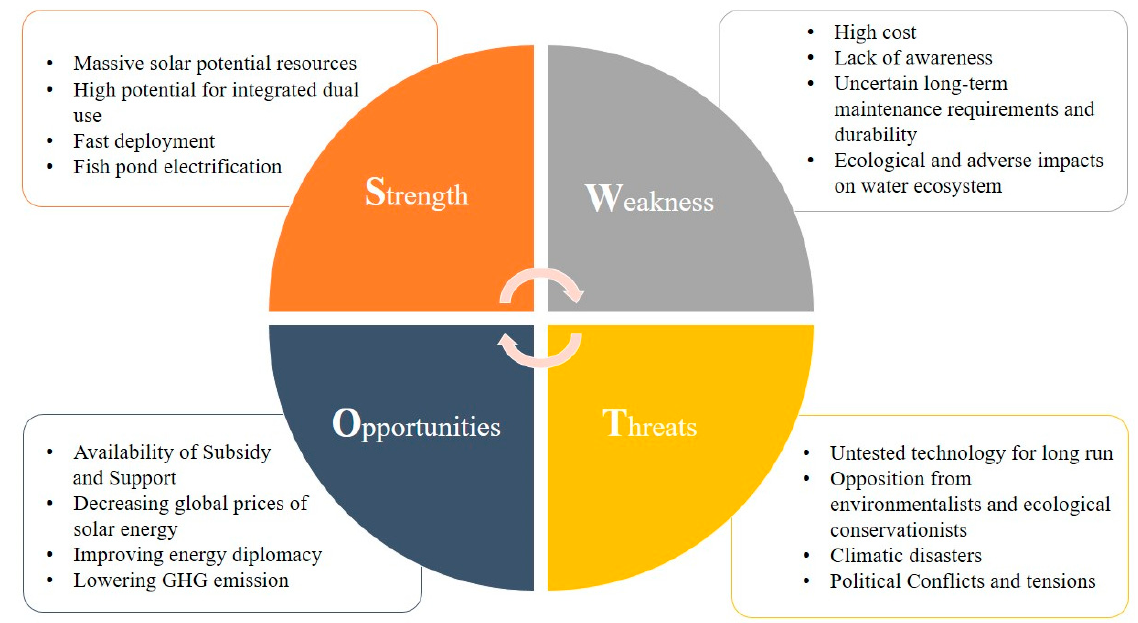
Figure 9. Factors identified in the SWOT (strength, weakness, opportunity, and threat) analysis for aquavoltaics.